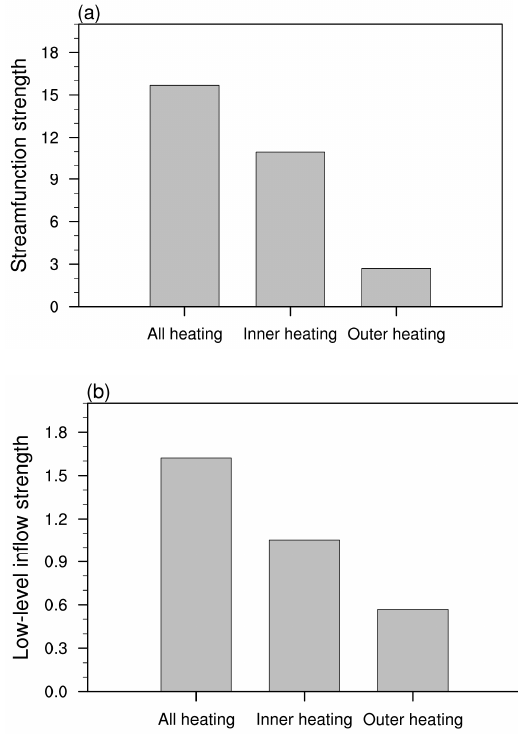
Figure 10. The change of ( a ) the stream function index (10 9 s − 1 ) and ( b ) the low-level inflow index (m s − 1 , absolute value) derived based on the SE equation in response to the total diabatic heating, the inner heating, and the outer heating shown in Figure 8c.